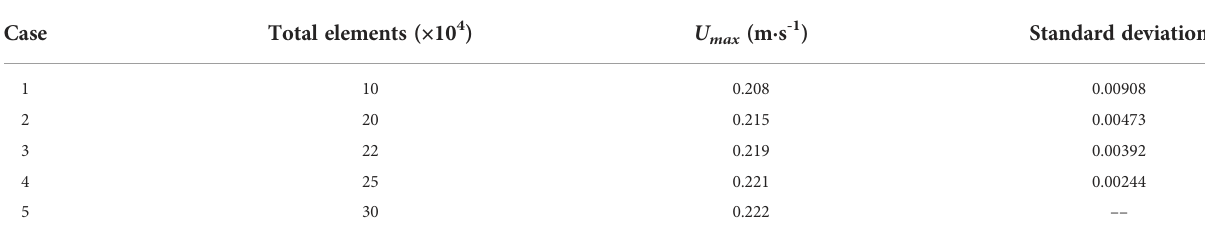
TABLE 1 Grid independence veri fi